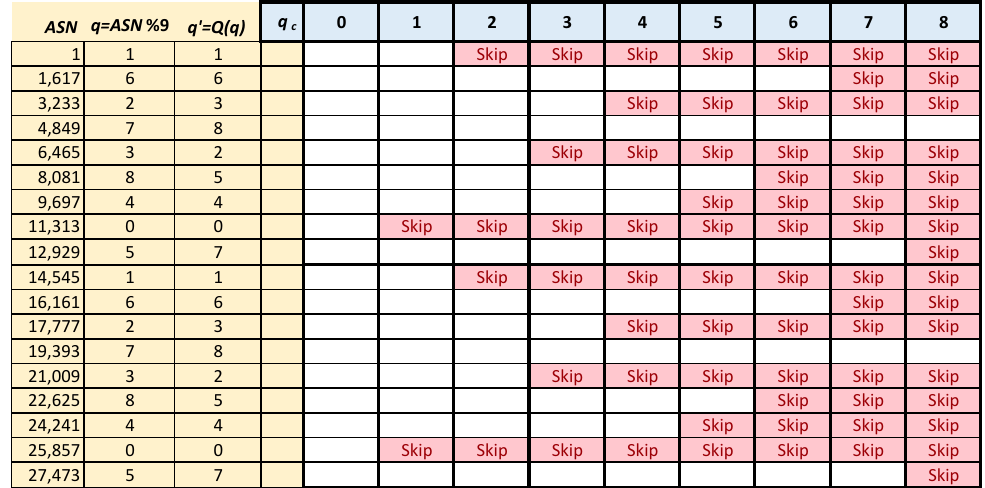
Figure 2. Sample sequence of cells skipped on channel c vs. quantized disturbance q c